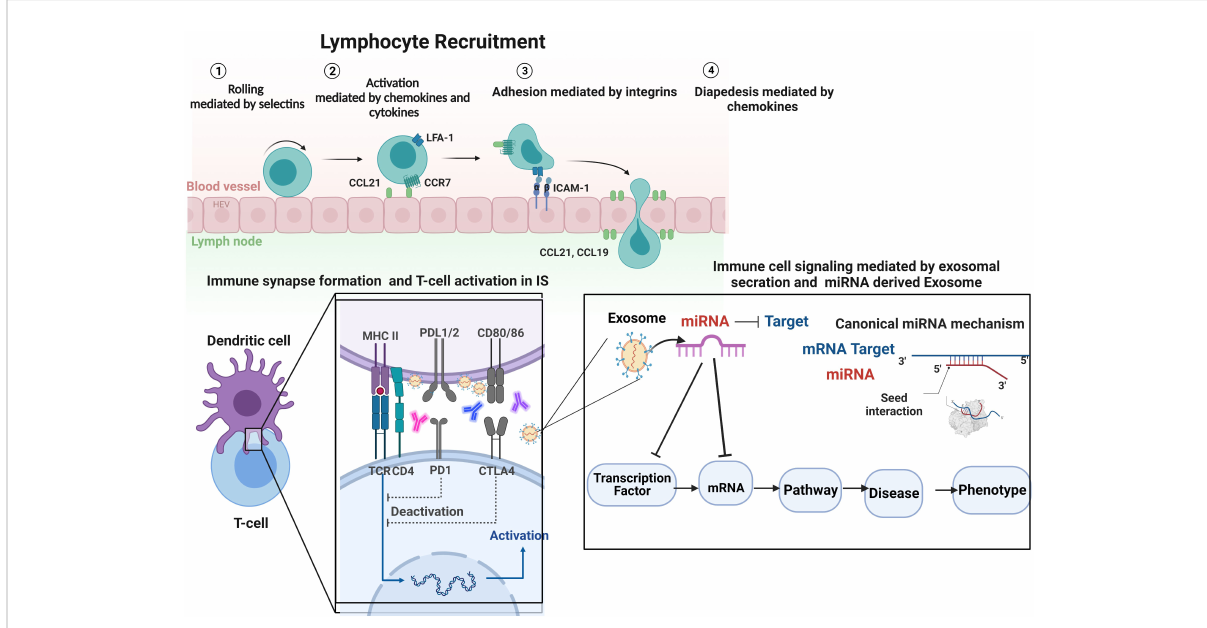
FIGURE 3 Regarding immune cell activity, integrin participation may be divided into three types of processes: immune cell recruitment, immune cell interactions, and immune cell signaling, followed by the formation of IS and biogenesis and secretion of exosomes in IS. T cell function is affected by three distinct activation signals: (1) recognition and binding of the antigen peptide (Ag) by the T cell receptor (TCR), resulting in the formation of the APC-T cell complex; (2) adjustment of the synapse by proteins CD28 and CD80/CD86; and (3) molecular interaction signaling APC release of in fl ammatory cytokines and exosomes, which activate T cell differentiation. A platform hypothesizes the potential impact of immune cell-derived exosomes containing miRNA on immune response initiation and immune system function and reprogramming the cells, which explains the model that prioritizes diseases and phenotypes based on miRNA-mRNA-disease associations. By analyzing the features of exosomes in individuals with AS in terms of the possibilities of utilizing exosomes as biomarkers and fi nding potential liquid biopsies, it may